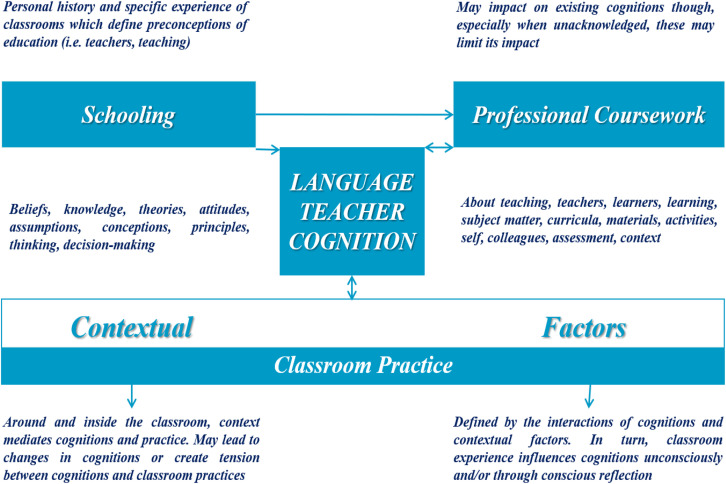
Elements and processes in language teacher cognition (adapted from Borg, 2015, p. 333).